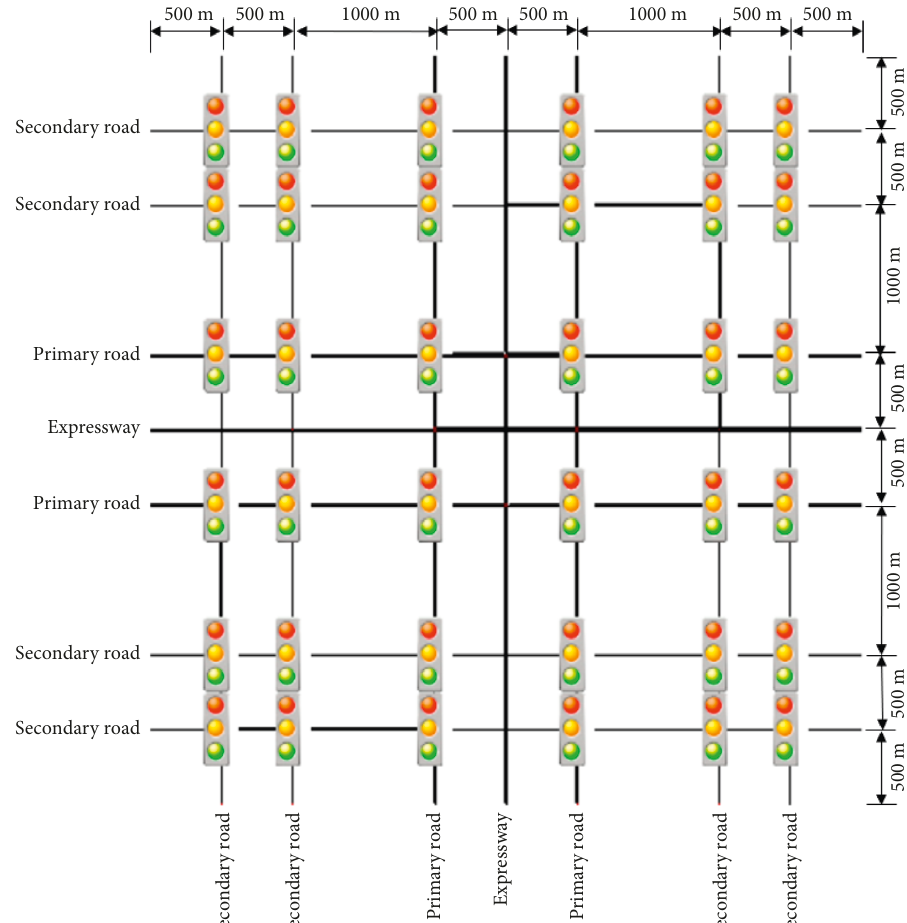
Figure 2: Ideal urban road network in